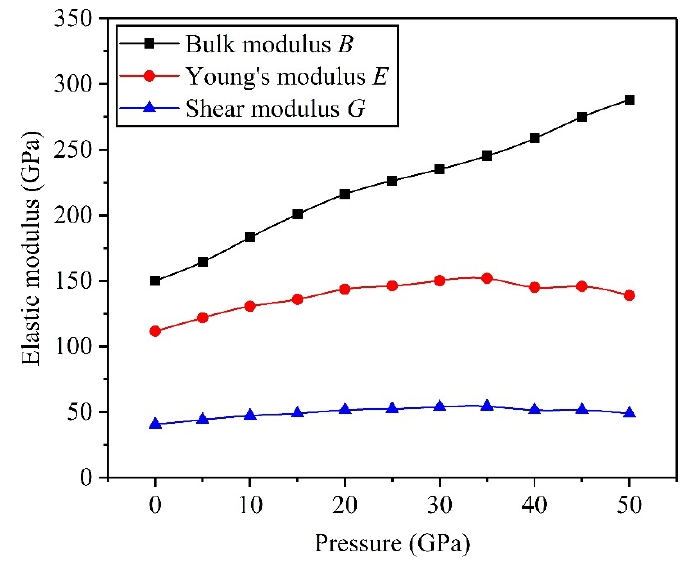
Figure 5. Variation curves of bulk modulus B , Young’s modulus E , and shear modulus G under different pressures for the NiTi SMA.